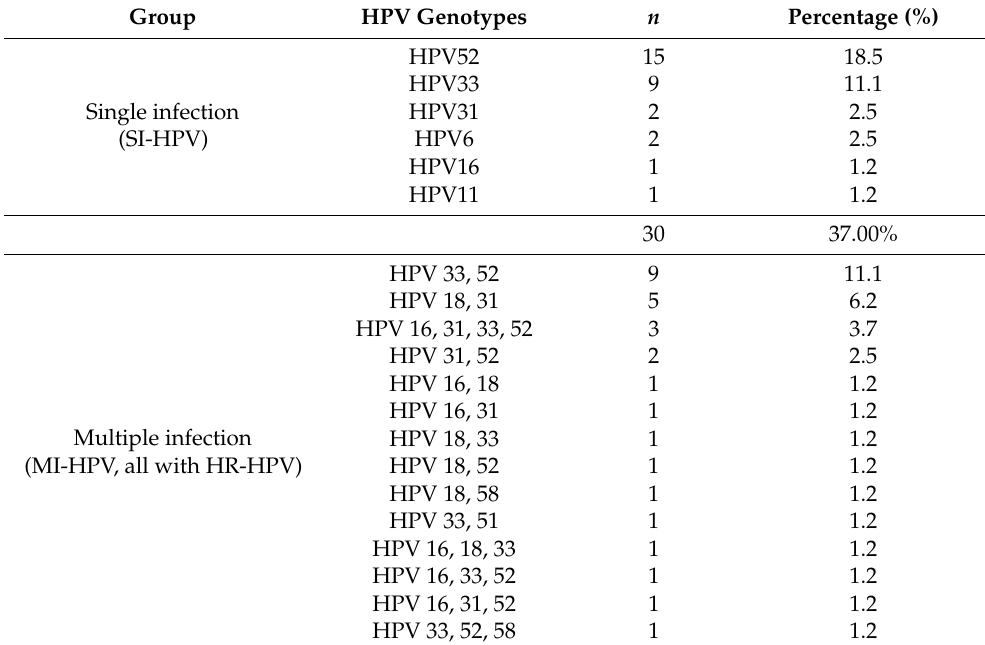
Table 1. Detected HPV genotypes in semen of the HPV-positive samples in the population.